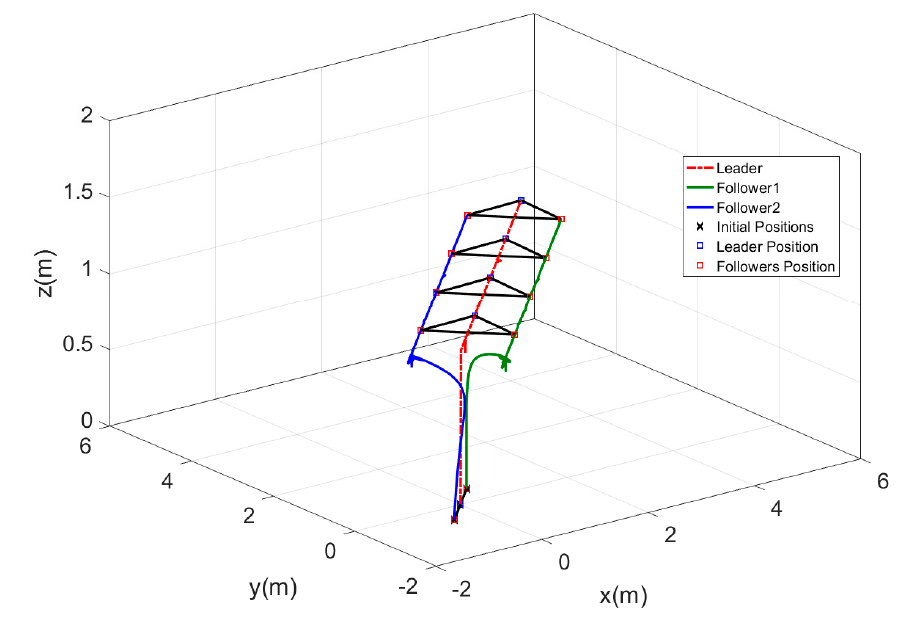
Figure 20. Three-dimensional view of fixed formation tracking with disturbances.